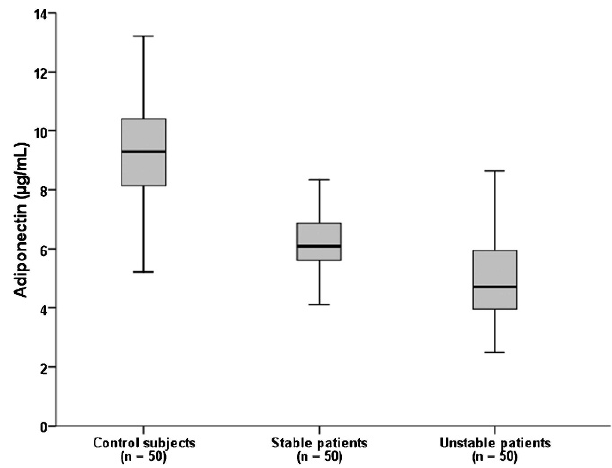
Figure 1 - Plasma adiponectin levels in unstable angina patients, stable angina patients and control subjects (ANOVA, p , 0.001